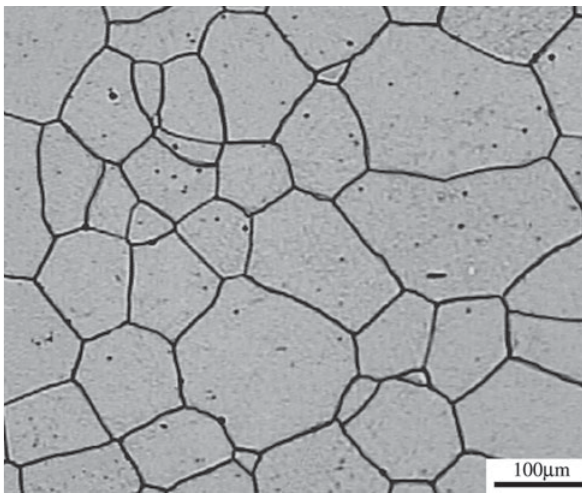
Figure 1. Typical microstructure of polycrystalline ZnO used in this work, after thermal etching at 1150 °C, for 1 h, in